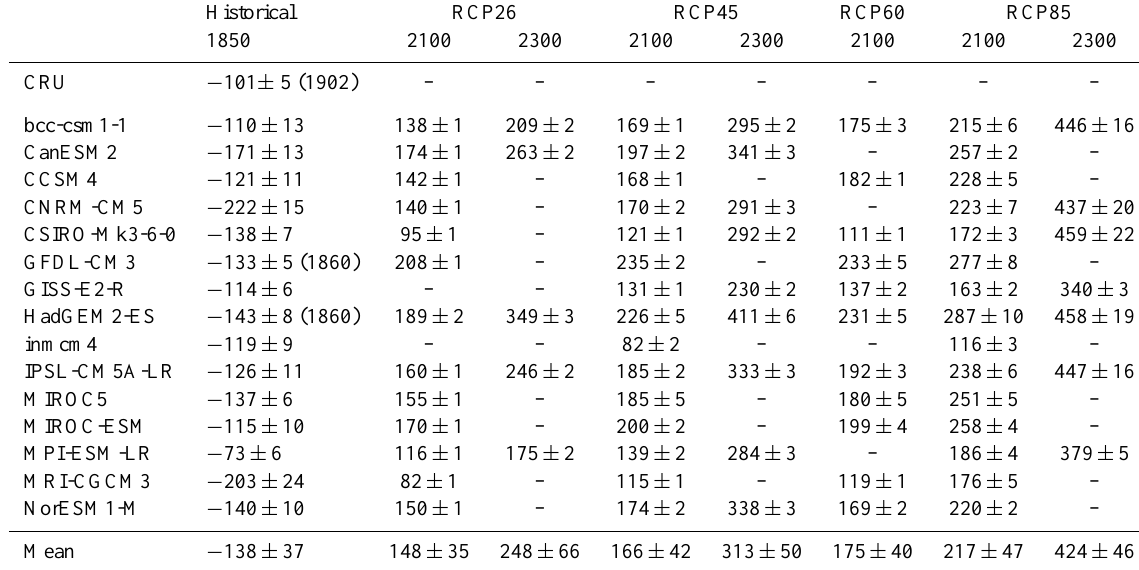
Table 5. Cumulative global sea-level equivalent mass losses in mm, relative to the 1986–2005 mean. Given errors for CMIP5-forced model runs are the propagated errors, for mean of CMIP5-forced model runs standard deviation between different